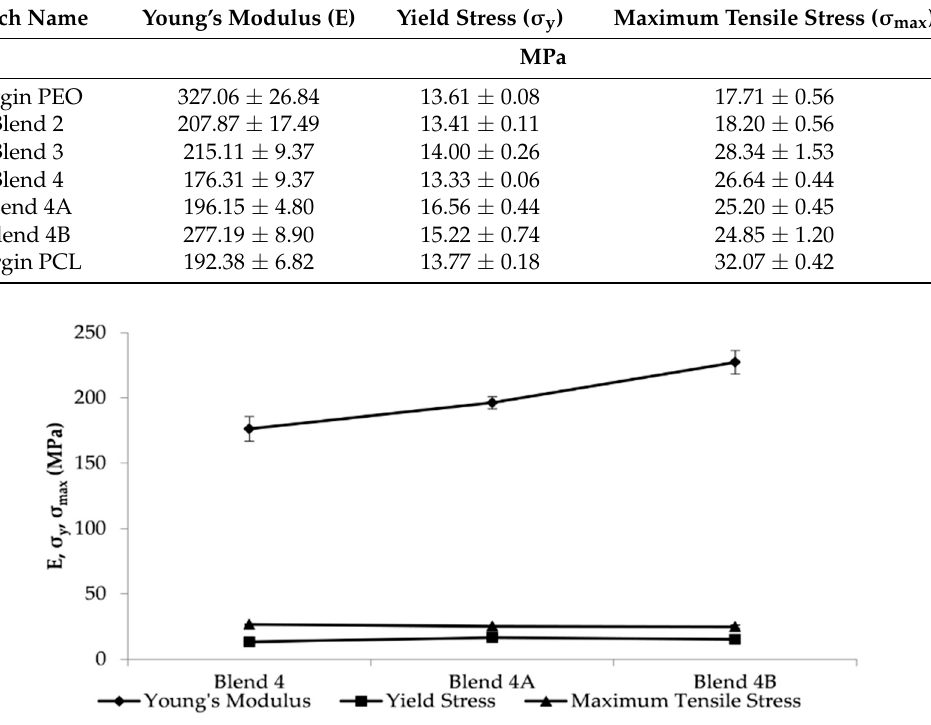
Figure 4. Selected mechanical data for the batches under investigation where, E represents Young’s modulus, σ y is the yield stress and σ max is the maximum tensile stress (n = 5). Table 5. Mechanical testing results of prepared batches.